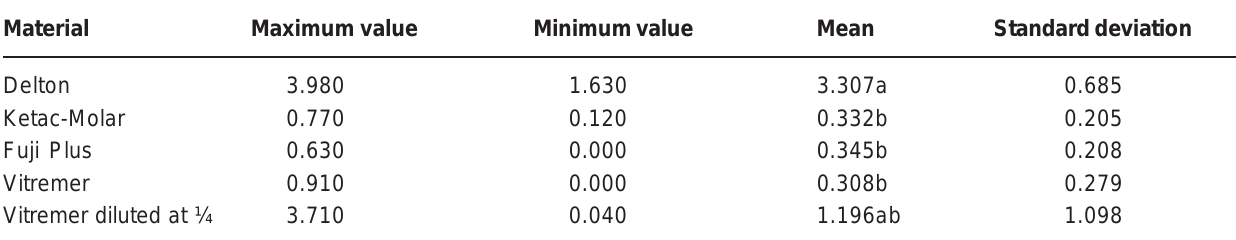
H=35.131 with 5 degrees of freedom (P<0.001)